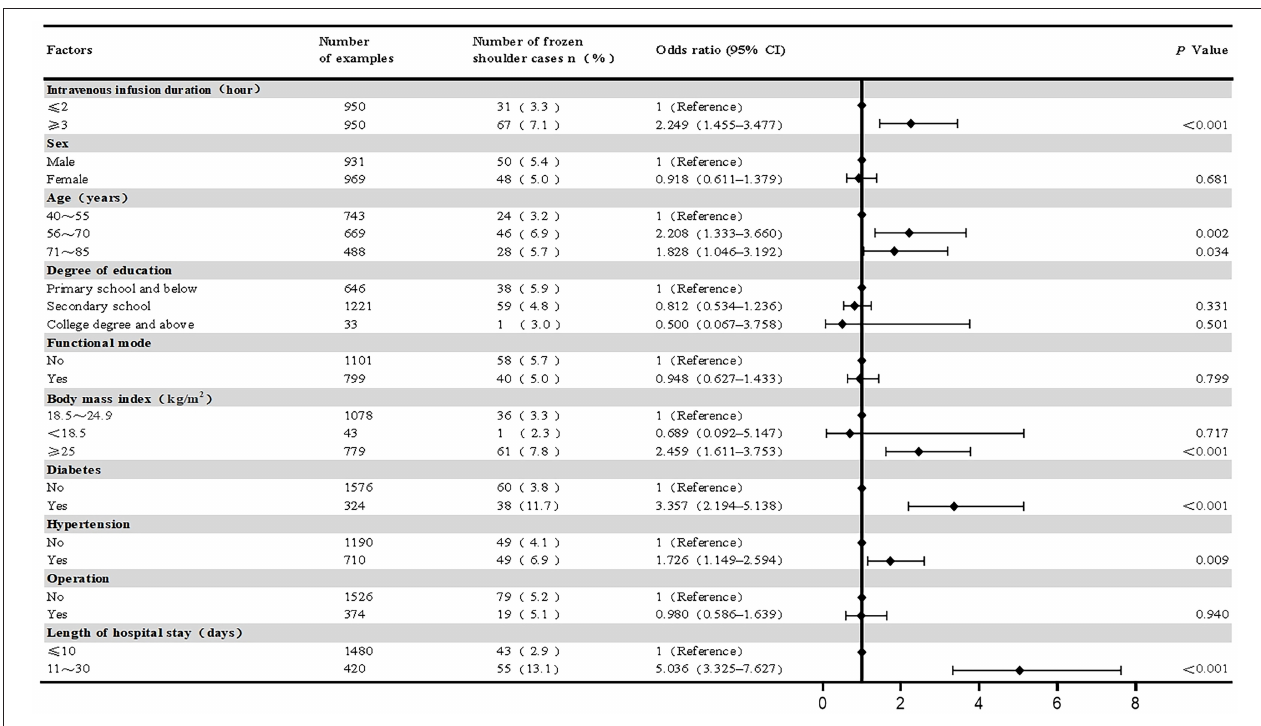
FIGURE 3 | Univariate binary logistic regression analysis on the risk of frozen shoulder in study